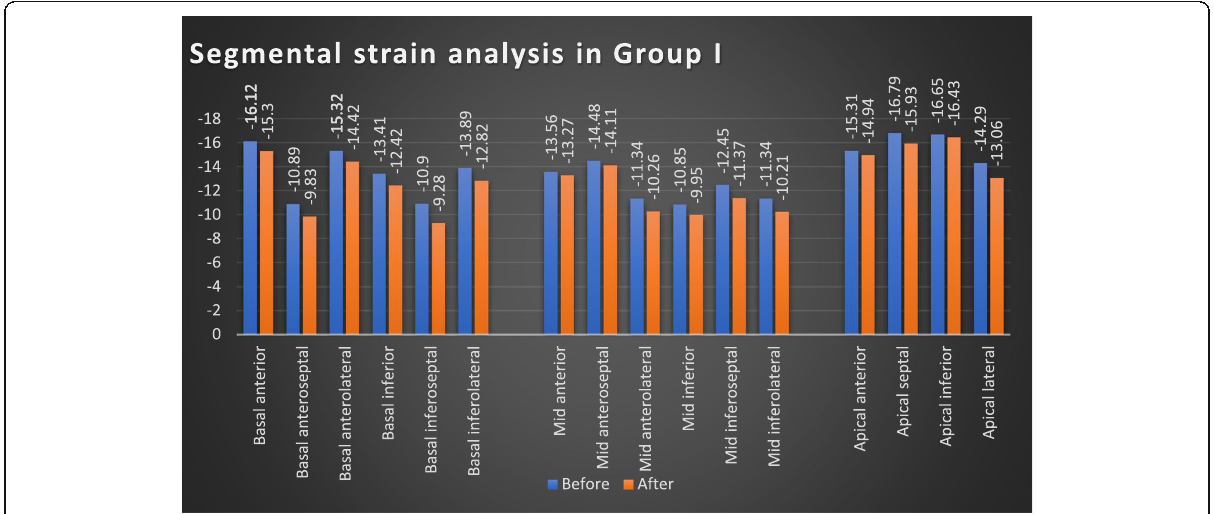
Fig. 1 Segmental strain analysis before and after receiving antiviral treatment in group